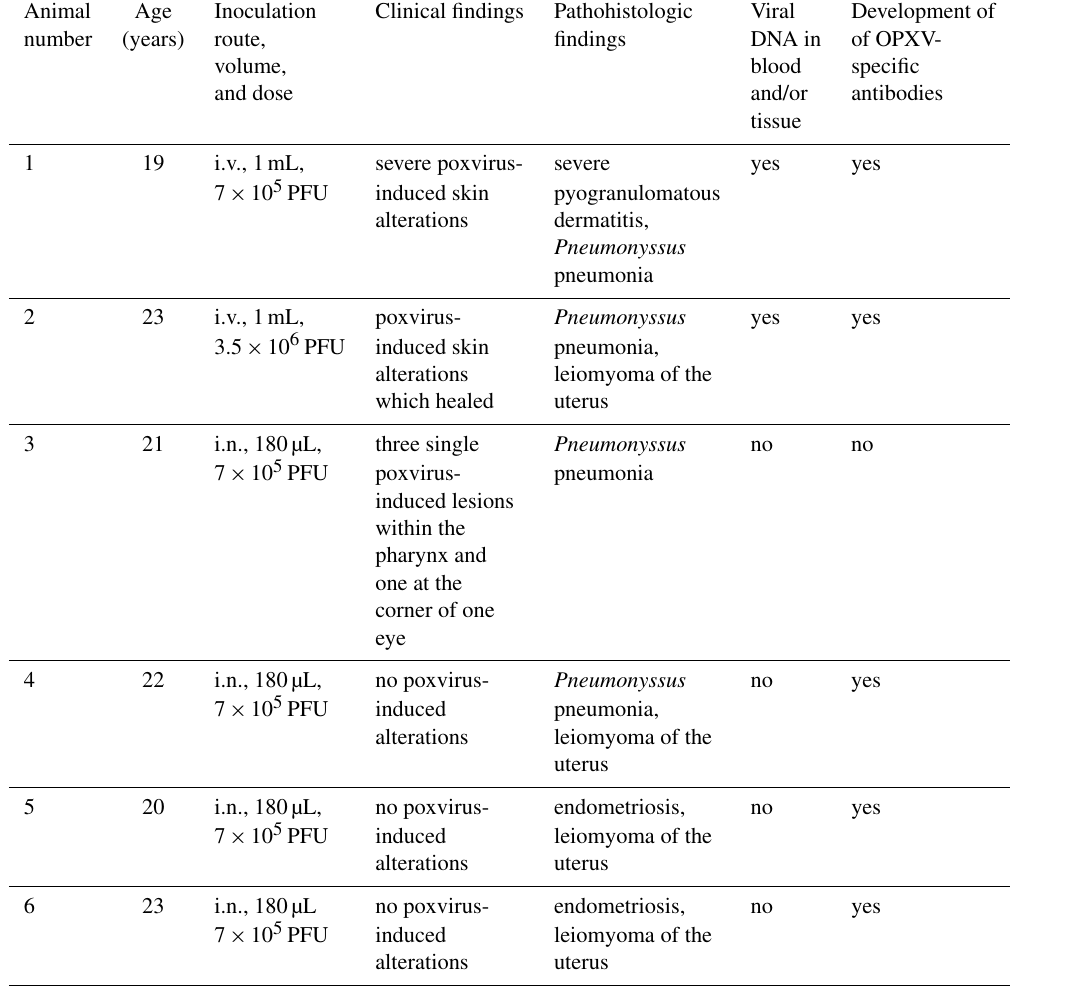
Table 1. Overview of inoculation route and clinical, pathohistological and virological findings.*